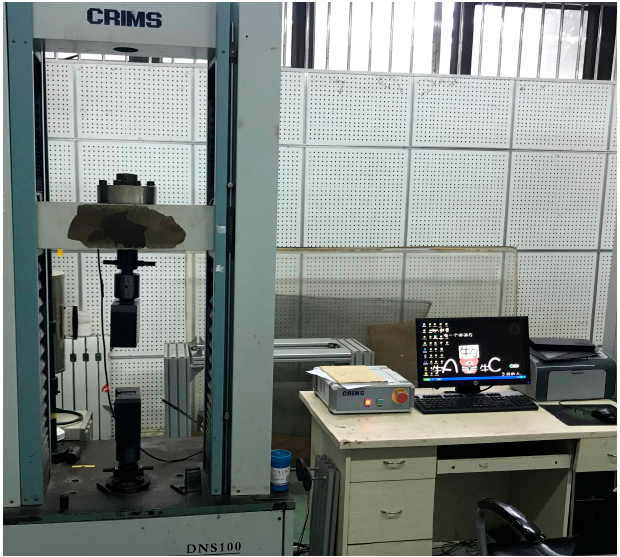
Figure 1. Experimental device diagram.